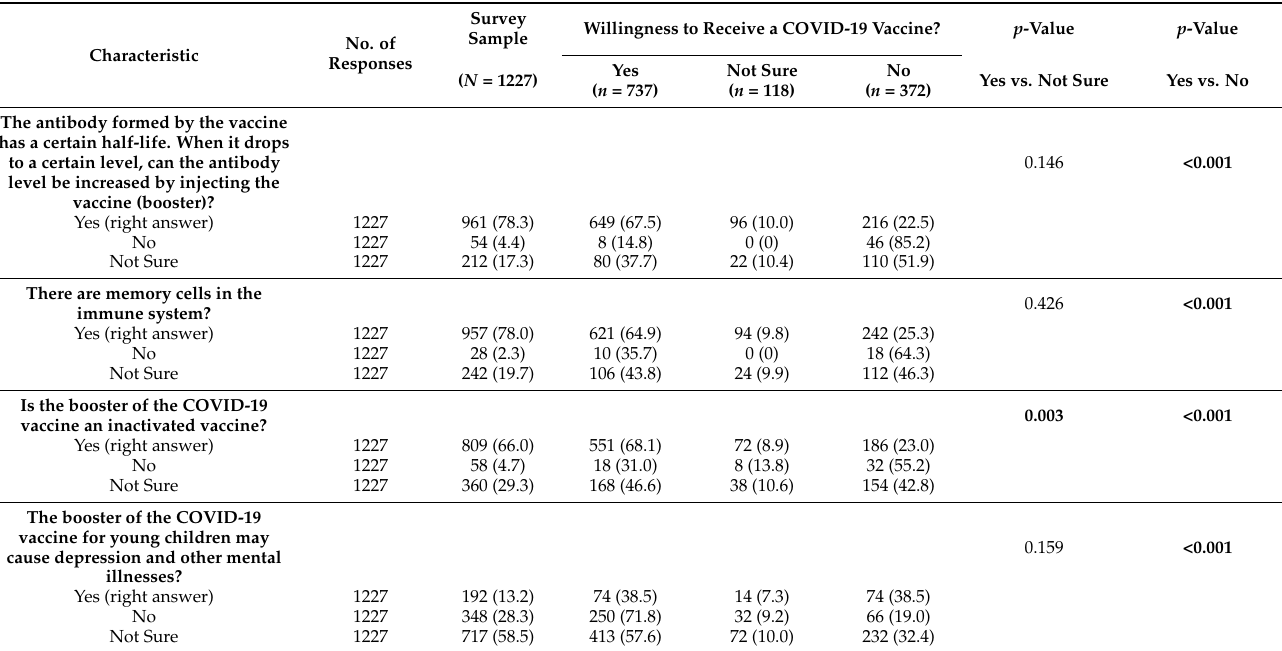
Table 5. t -test on vaccine medical knowledge and willingness to the vaccine booster